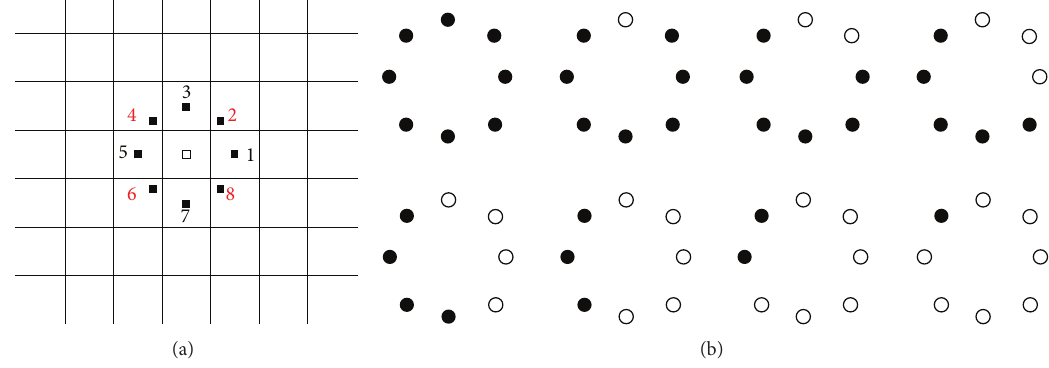
two. Different uniform patterns are counted into different bins, and all nonuniform patterns are voted into one